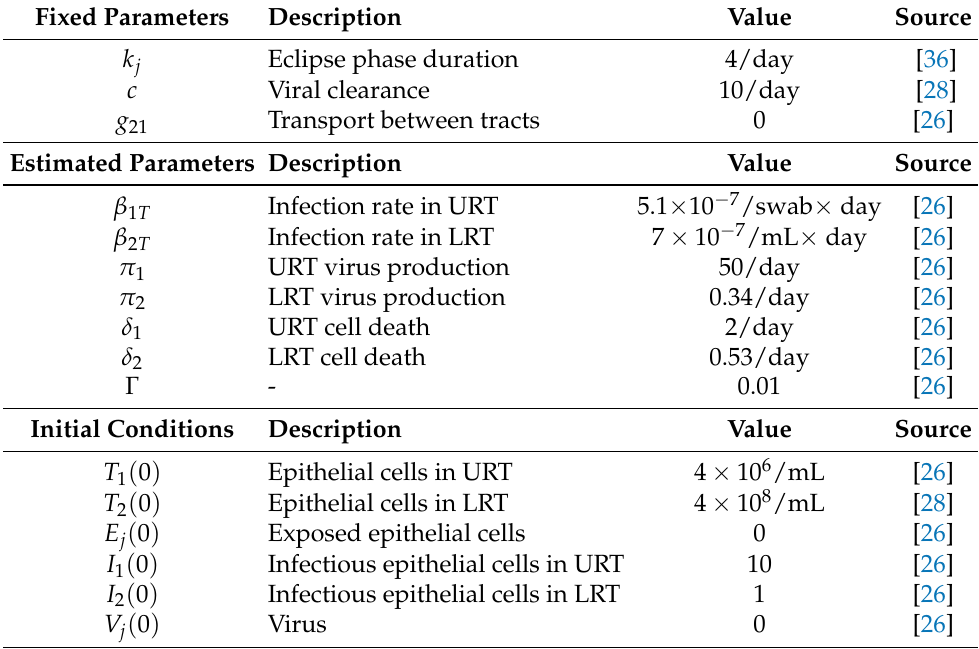
Table 1. Parameter values and initial conditions used in model